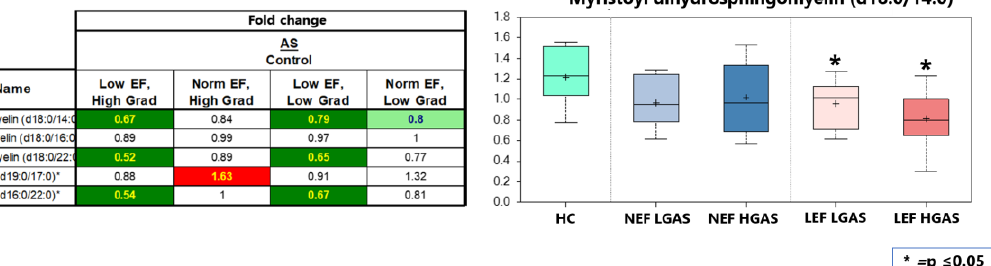
Figure 6. Metabolites with different serum levels between AS subgroups. ( A ) List of altered hemoglobin related metabolites. Bilirubin and biliverdin are illustrated as examples. ( B ) List of altered diacylglycerols (DAGs) in AS patients. ( C ) List of altered dihydrosphingomyelins (DHSMs) in AS subgroups. Myristoyl dihydrosphingomyelin is illustrated as an example. Significantly, up- and downregulated molecules are marked in red and green, respectively. Values marked in light red and light green indicate a trend towards statistical significance (0.05 < p < 0.10). Non-colored values are not significantly different for that comparison. Numbers indicate x-fold increase/decrease in concentration. On each box, the black cross indicates the mean value, the borders and segmentation indicate limits of upper/lower quartile and median values. Outliers are plotted as circles. Asterix (*) indicates p ≤ 0.05 between the annotated group and the control group.